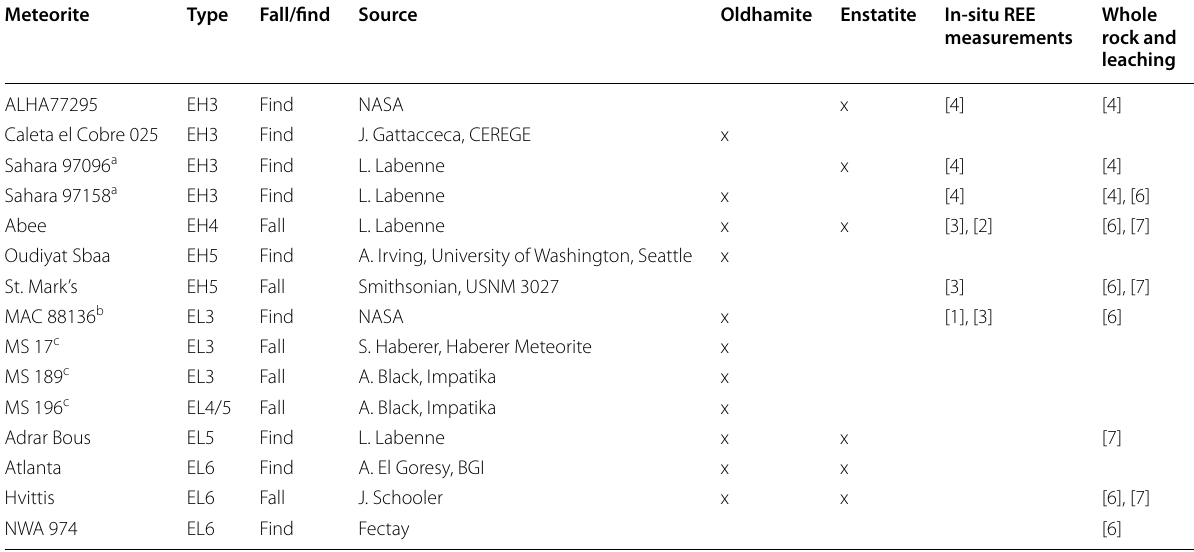
Table 1 List of samples analyzed minerals in this